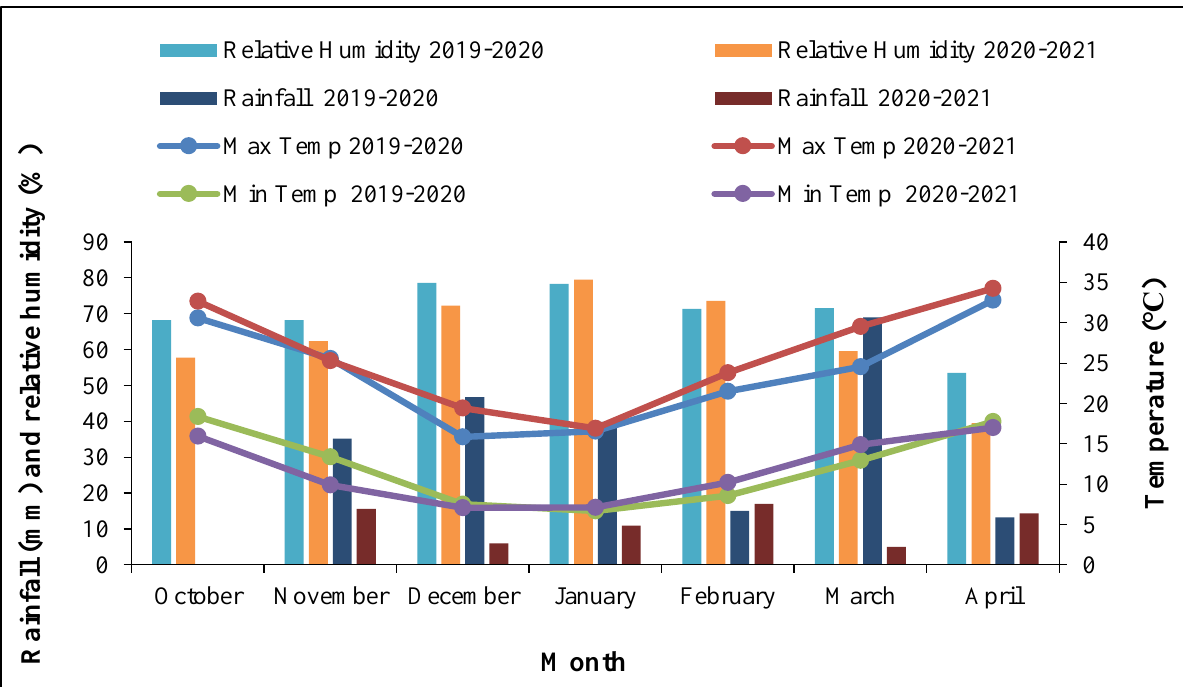
Figure 1. Monthly average maximum and minimum temperature, relative humidity and rainfall of the study area. Note: Max, Maximum; Min, Minimum; Temp, Temperature